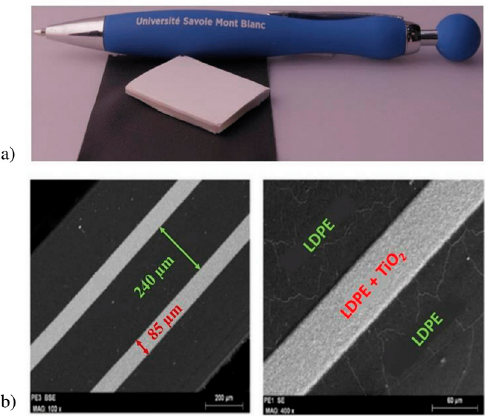
Figure 1. ( a ) Picture of the realized multilayer tag; ( b ) microscope images of stacked layers made of pure LDPE and TiO 2 + LDPE mixture. © 2021 IEEE: this figure is plotted from [24].